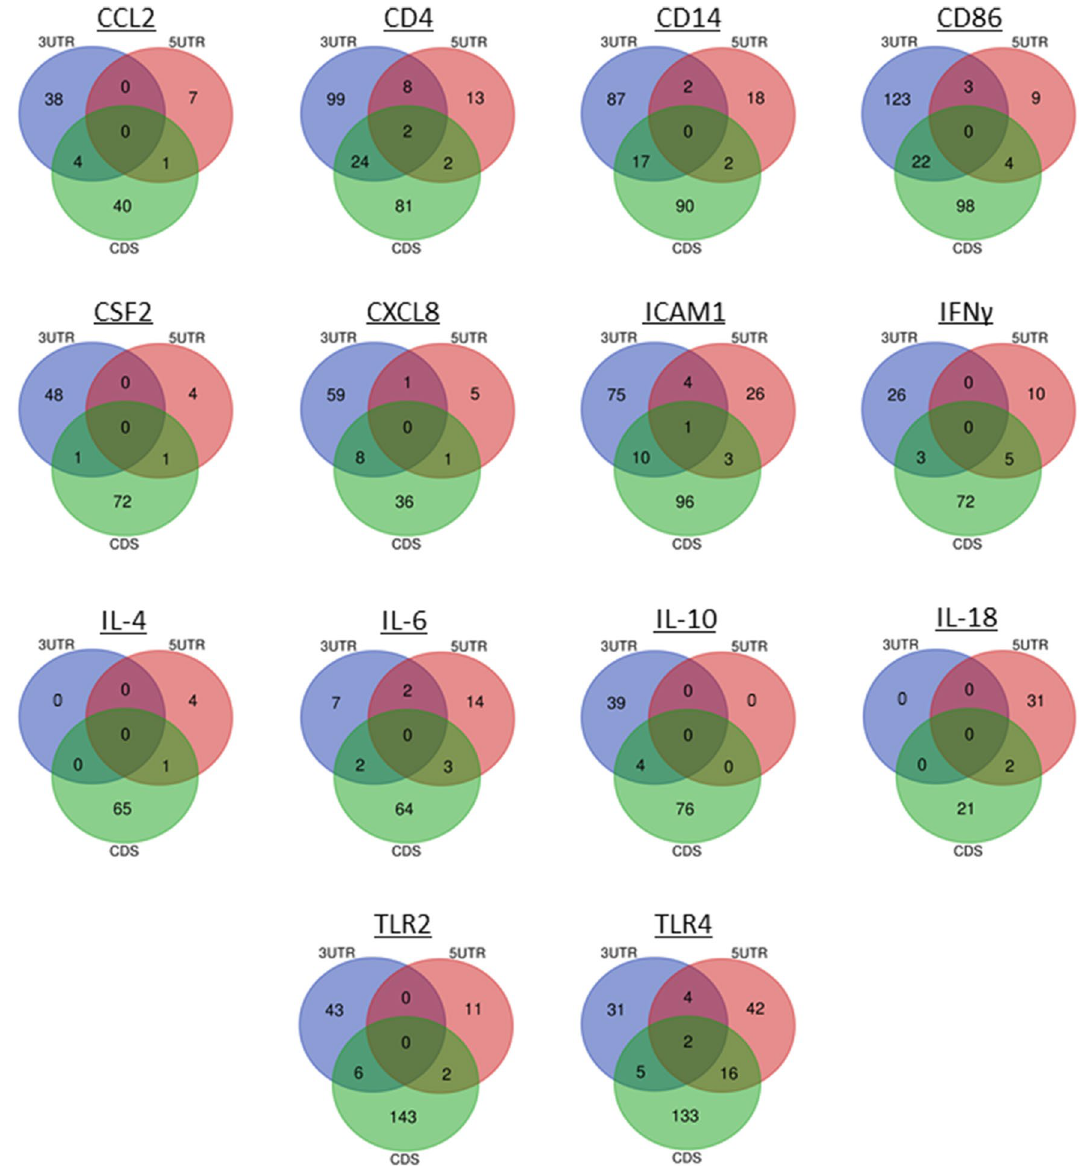
Figure 3. Venn Diagrams (http:// bioin forma tics. psb. ugent. be/ webto ols/ Venn/) for 14 out of 16 target bovine mastitis genes showing the number of miRNA binding to the 3 ′ UTR, CDS, and 5 ′ UTR. The overlapping region of each diagram represents miRNA that bind to all three regions of the target